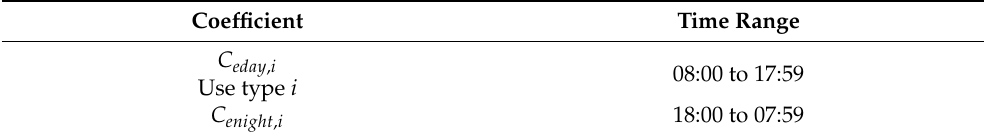
Table 2. Electricity demand critical